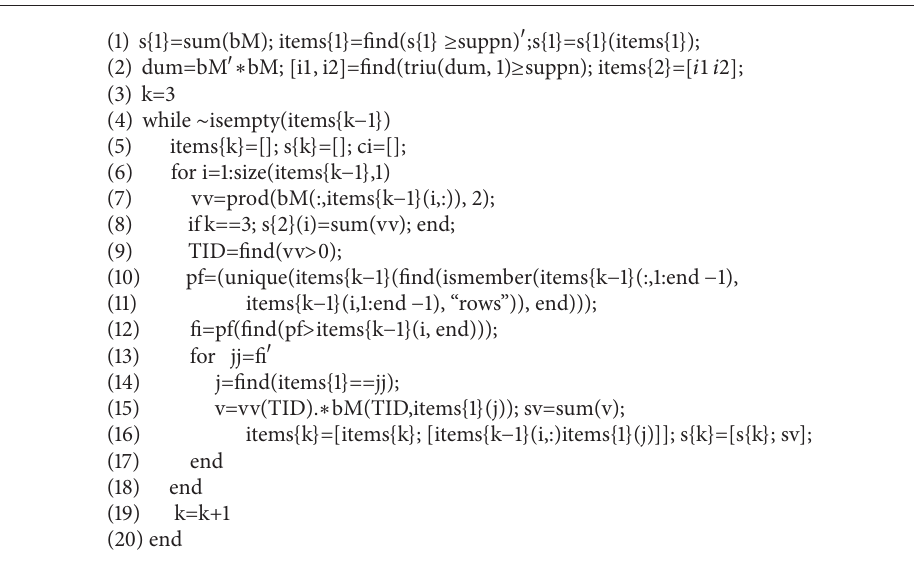
Algorithm 1: MATLAB code 2: mining frequent itemsets.